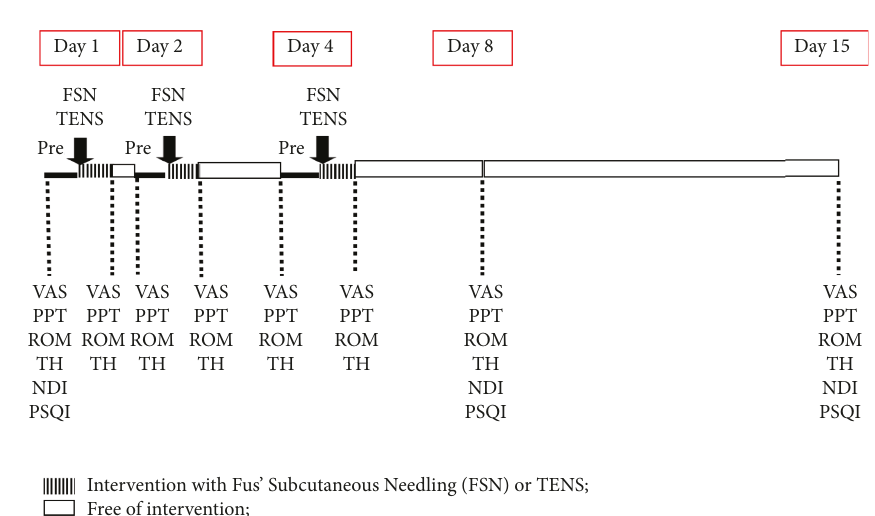
Figure 1: Consort flow diagram.